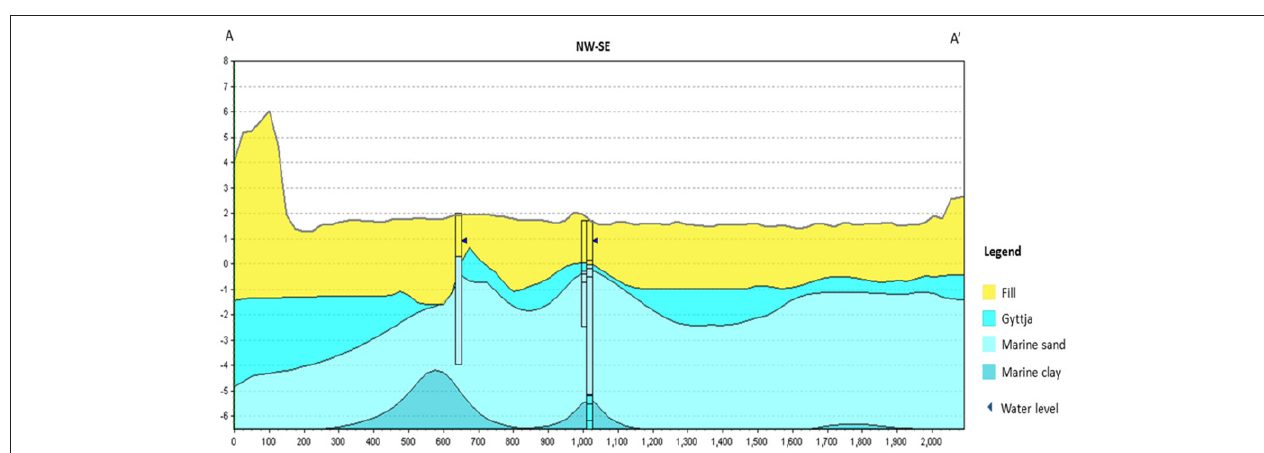
FIGURE 8 | Geological profile A-A ′ of the upper 7m stretching from NW to SE (unit m on both axes). The geological profile includes wells from Geo’s well database with a projection distance of less than 10m. The blue triangle represents the water level observed in the wells.